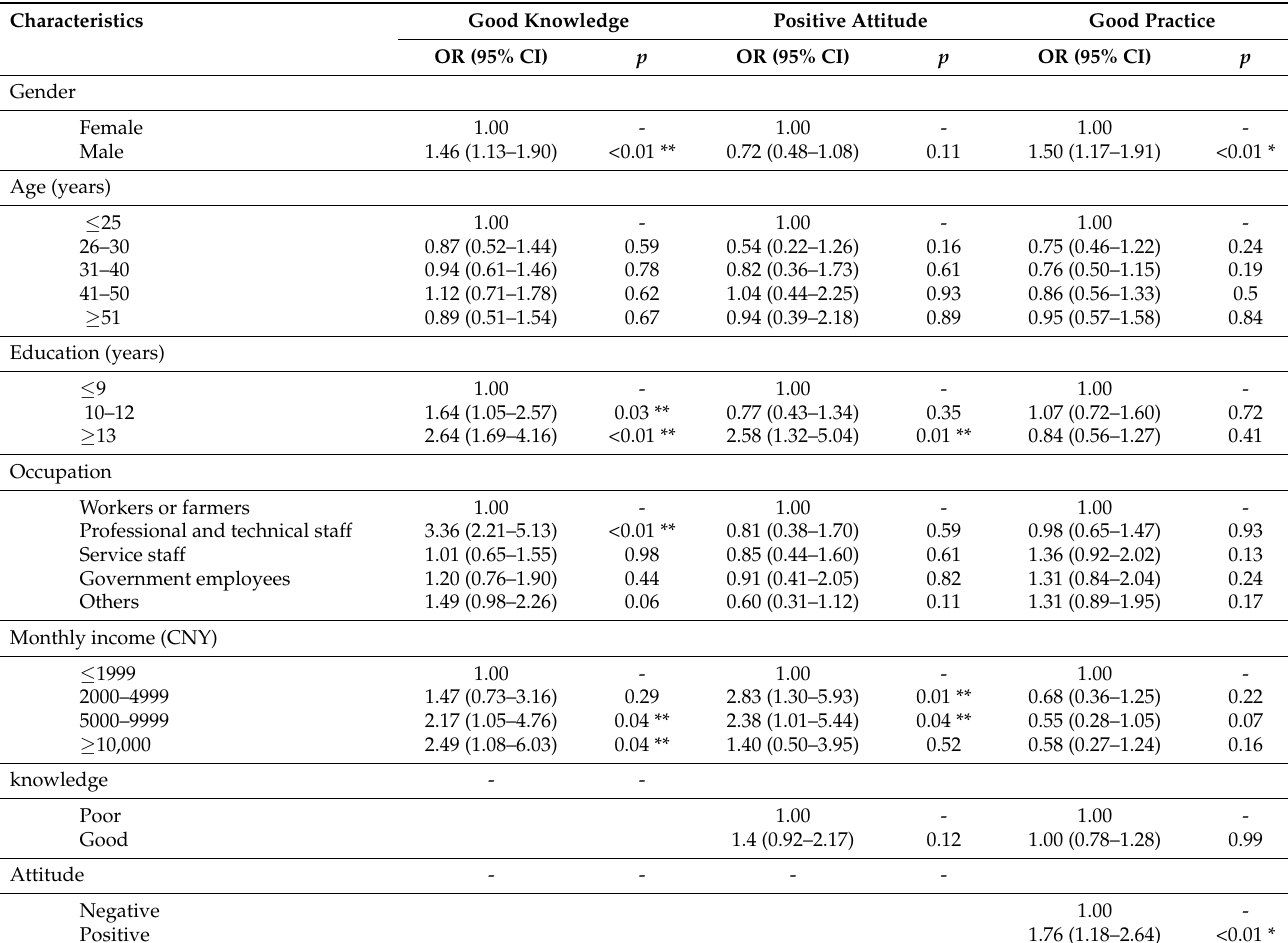
Table 3. Multiple logistic regression on factors significantly associated with good KAP towards public emergency.